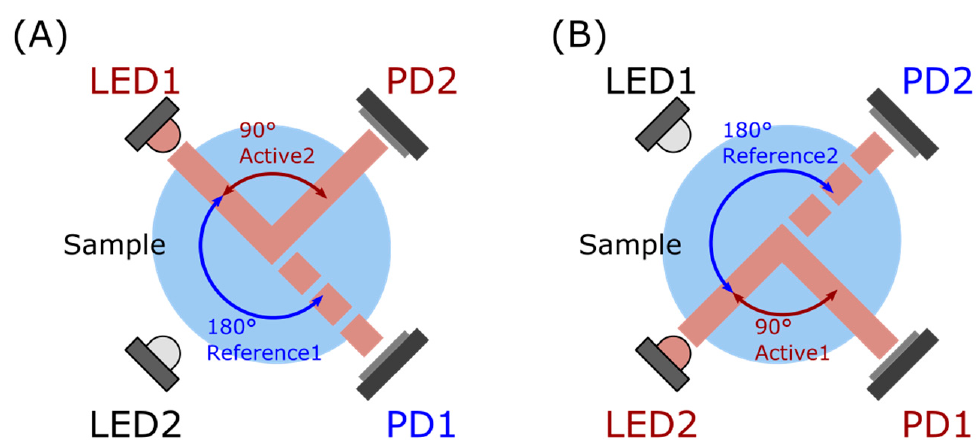
Figure 2. Illustration of the GLI-2 method, a ratiometric method based on a modulated 4-beam design. ( A ) Phase one: light source LED1 is on, photodetector PD2 measures the Active2 signal (90° nephelometric), and photodetector PD1 the Reference1 signal (180° attenuation). ( B ) Phase two: light source LED2 is on, photodetector PD2 is the Reference2 signal (180° attenuation), and photodetector PD1 is the Active1 signal (90° nephelometric).